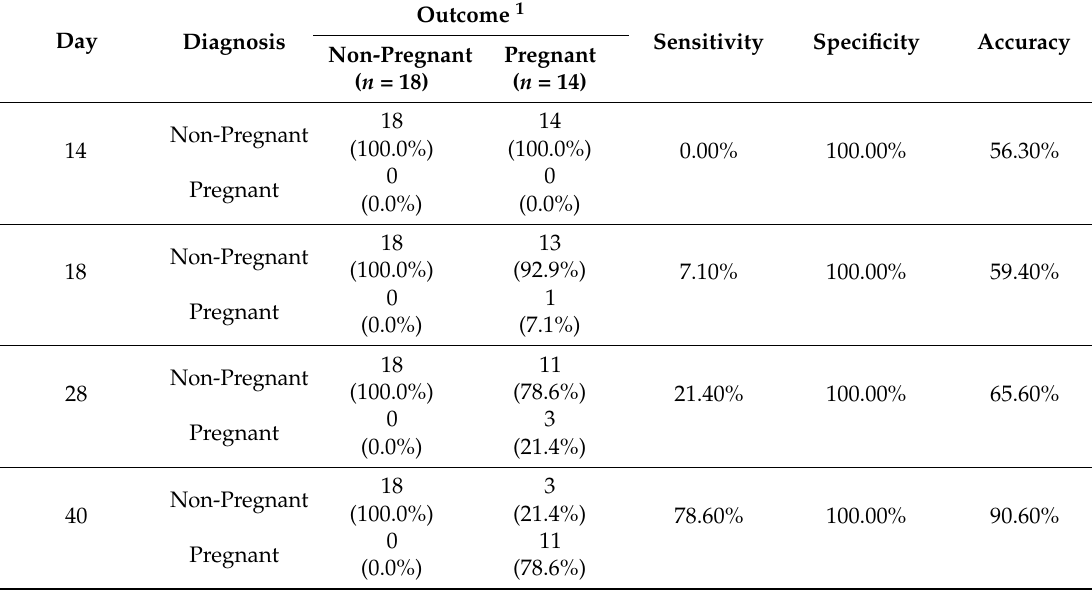
Figure 1. PAG-2 concentrations until Day 40 post AI in the pregnant and non-pregnant group (mean ± SE, row data) evaluated with the radioimmunoassay (RIA) system. *** p < 0.001. ** p < 0.01 Pregnant vs. Non-pregnant at each day (Sidak correction). The dotted line indicates the threshold for the pregnancy diagnosis (1.0 ng/mL). Table 2. Sensitivity, specificity, and accuracy of PAG-2 determined by RIA for pregnancy diagnosis in buffaloes 14, 18, 28, and 40 days post-insemination (threshold = 1.0 ng/mL).